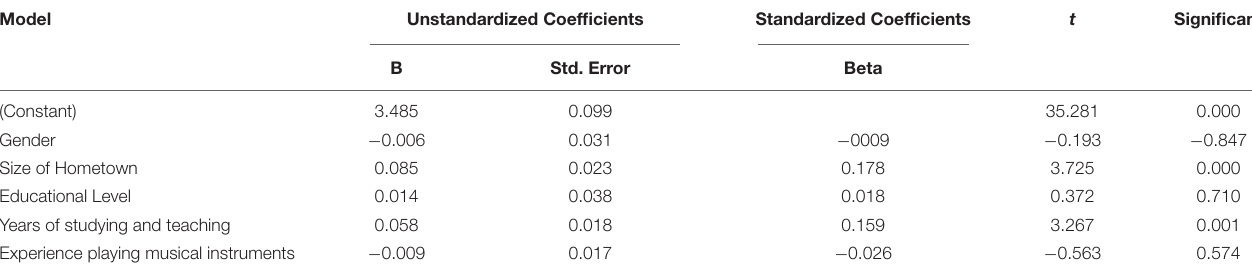
TABLE 5 | Regression coefficients for demographic characteristic on the multicultural personality questionnaire-short from.